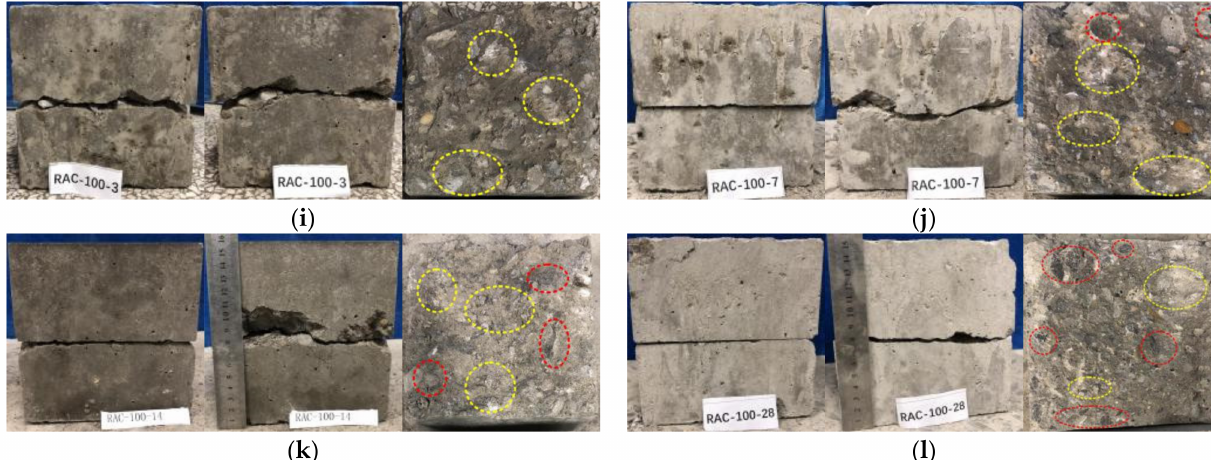
Figure 4. Typical failure patterns of specimens at different replacement ratios: ( a ) Failure patterns of RAC-0 at 3 days. ( b ) Failure patterns of RAC-0 at 7 days. ( c ) Failure patterns of RAC-0 at 14 days. ( d ) Failure patterns of RAC-0 at 28 days. ( e ) Failure patterns of RAC-50 at 3 days. ( f ) Failure patterns of RAC-50 at 7 days. ( g ) Failure patterns of RAC-50 at 14 days. ( h ) Failure patterns of RAC-50 at 28 days. ( i ) Failure patterns of RAC-100 at 3 days. ( j ) Failure patterns of RAC-100 at 7 days. ( k ) Failure patterns of RAC-100 at 14 days. ( l ) Failure patterns of RAC-100 at 28